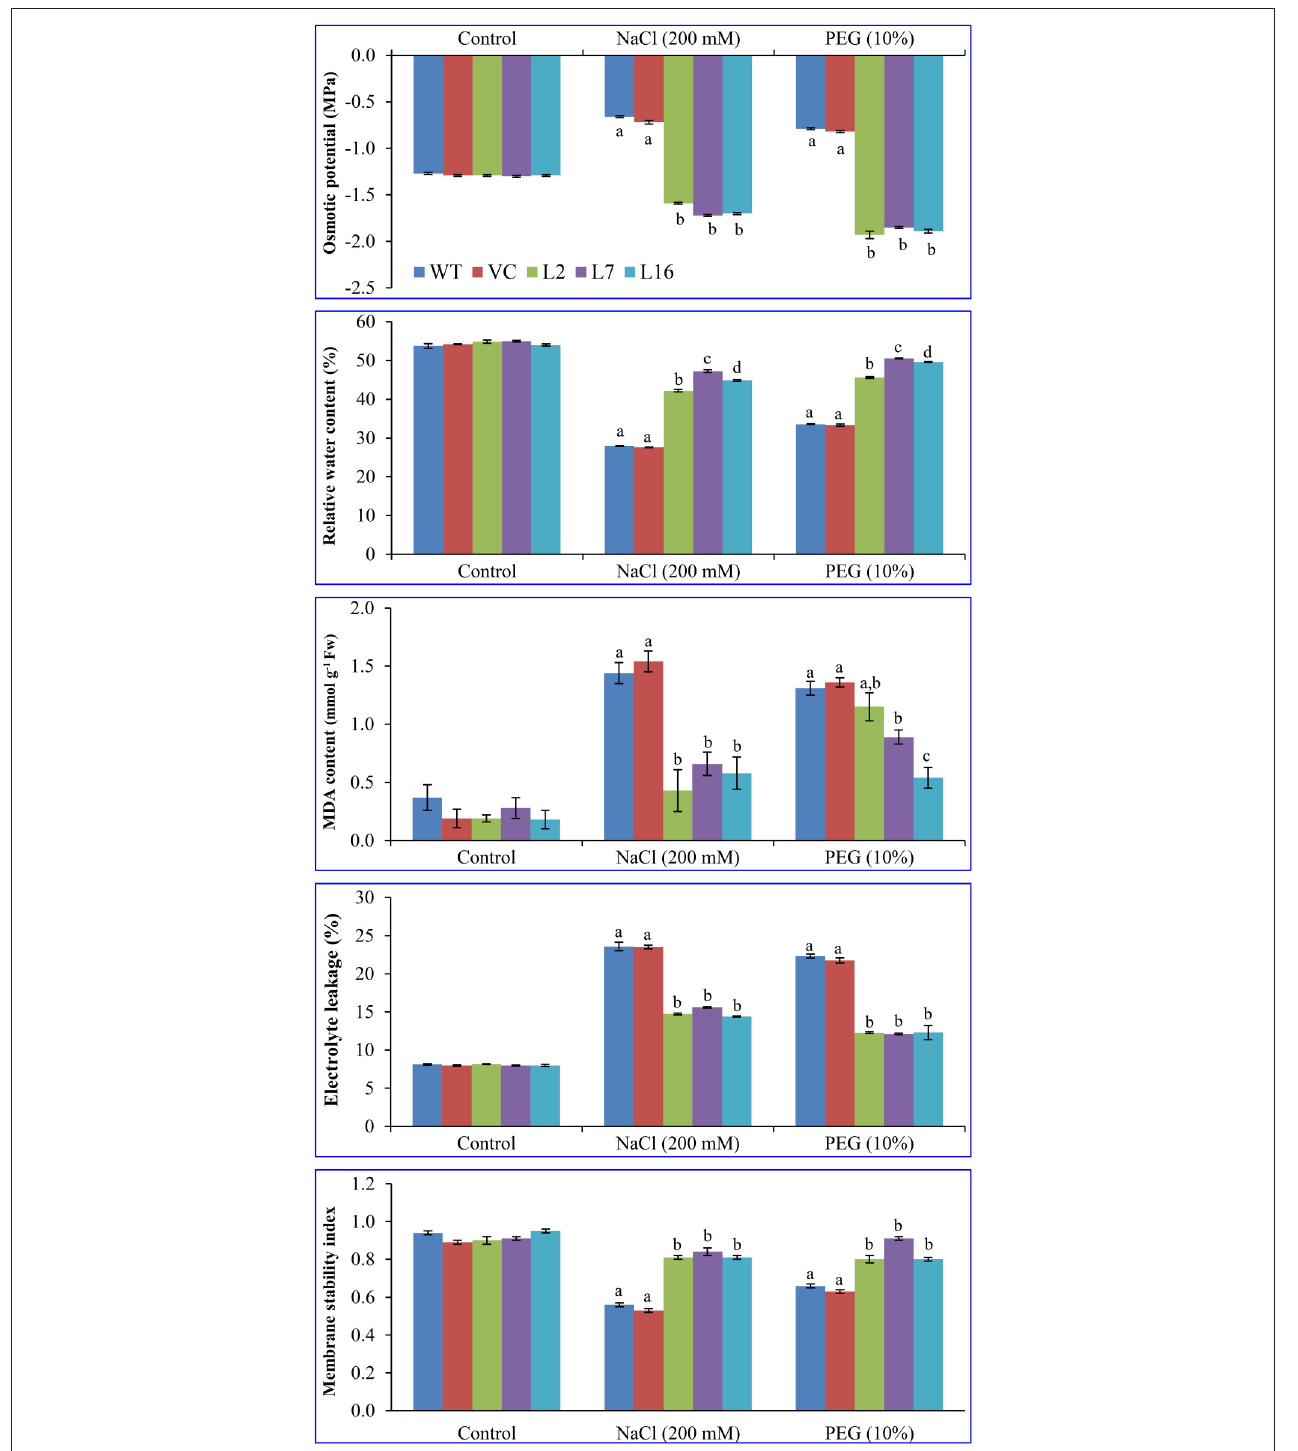
FIGURE 4 | Physiological analyses of transgenic lines. Estimation of osmotic potential (OP), relative water content (RWC), lipid peroxidation (MDA content), electrolyte leakage (EL), and membrane stability index (MSI) from leaves of control plants (WT and VC) and transgenic lines (L2, L7, and L16) under control, salinity and osmotic stress conditions. Bars represent means ± SE and values with different letters are significant at P < 0.05.